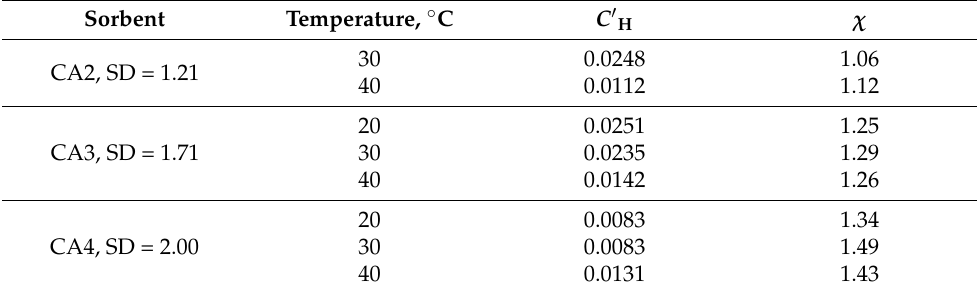
Figure 4. Dependence of sorption capacity of cellulose esters on the substitution degree at different p / p s : 1 — 0.2; 2 — 0.4; 3 — 0.7; 4 — 0.8; 5 — 0.9. Table 4. Characteristics of isotherms of water vapour sorption by CA.